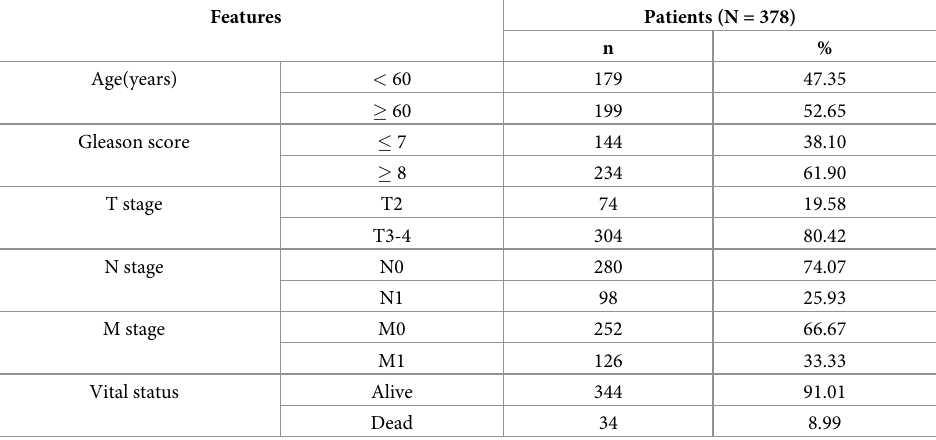
Table 2. PCa patients from ICGC database clinicopathological